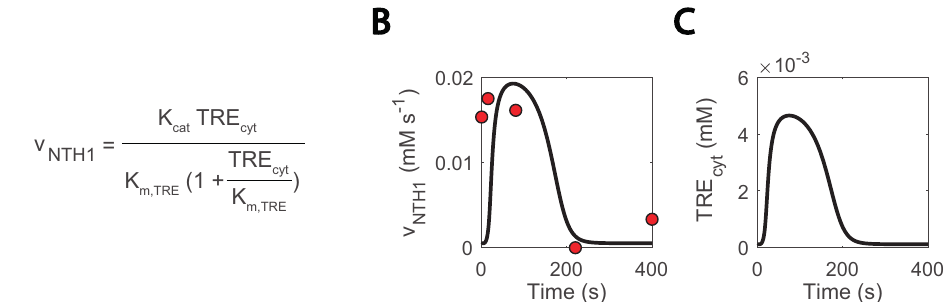
Figure 8. Missing regulation on NTH1 could explain excessively low simulated cytosolic trehalose concentrations: ( A ) NTH1 reaction kinetics; ( B ) NTH1 reaction rate; ( C ) cytosolic trehalose; blank lines show simulations, and red dots experimental